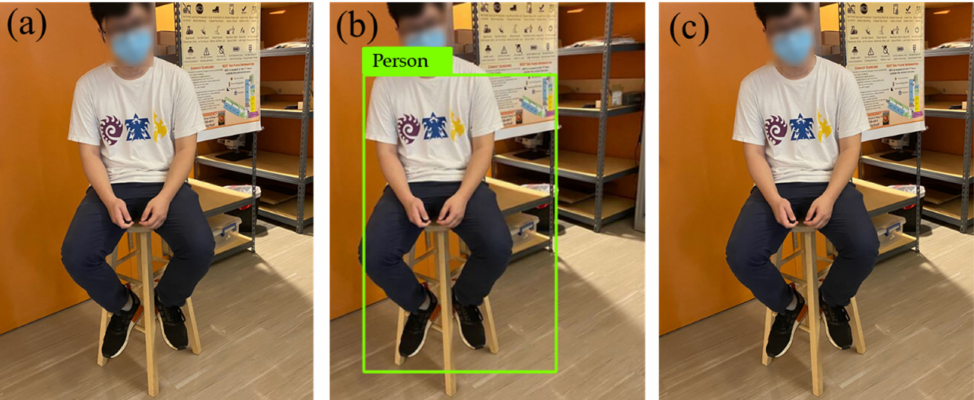
Figure 4. ( a ) Original image of a person sitting on a chair; ( b ) image recognition result with Deep Learning; ( c ) UV disinfection is turned off because a person has been